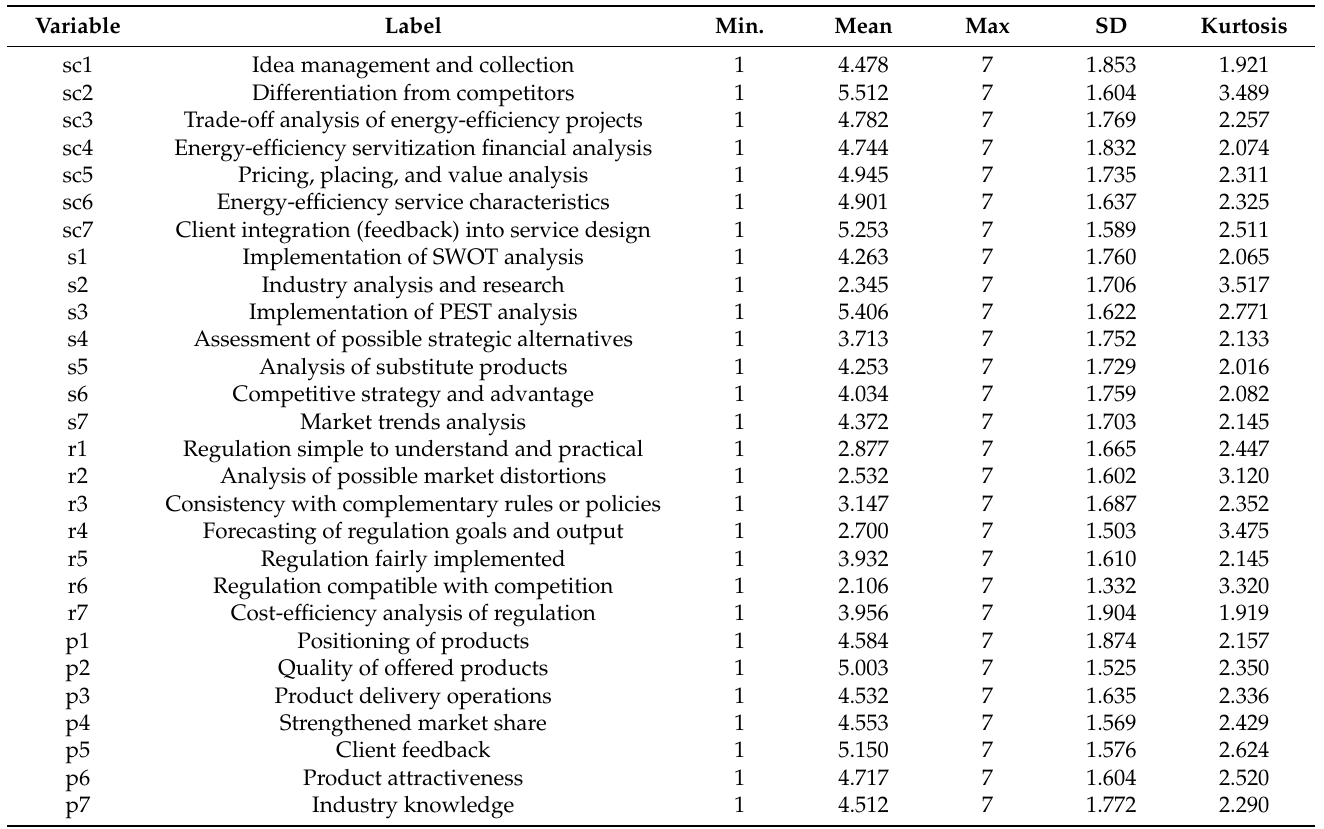
Table 1. List of variables and key